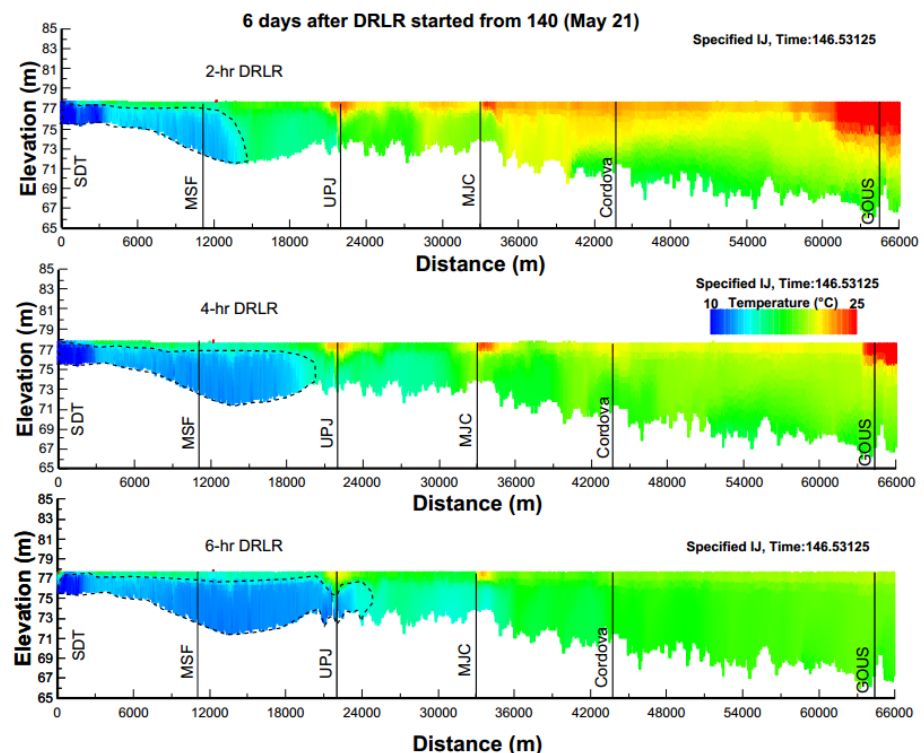
Figure 8. Simulated water temperature distributions for 2-h, 4-h and 6-h DRLRs lasting for six days from Julian Day 140 (21